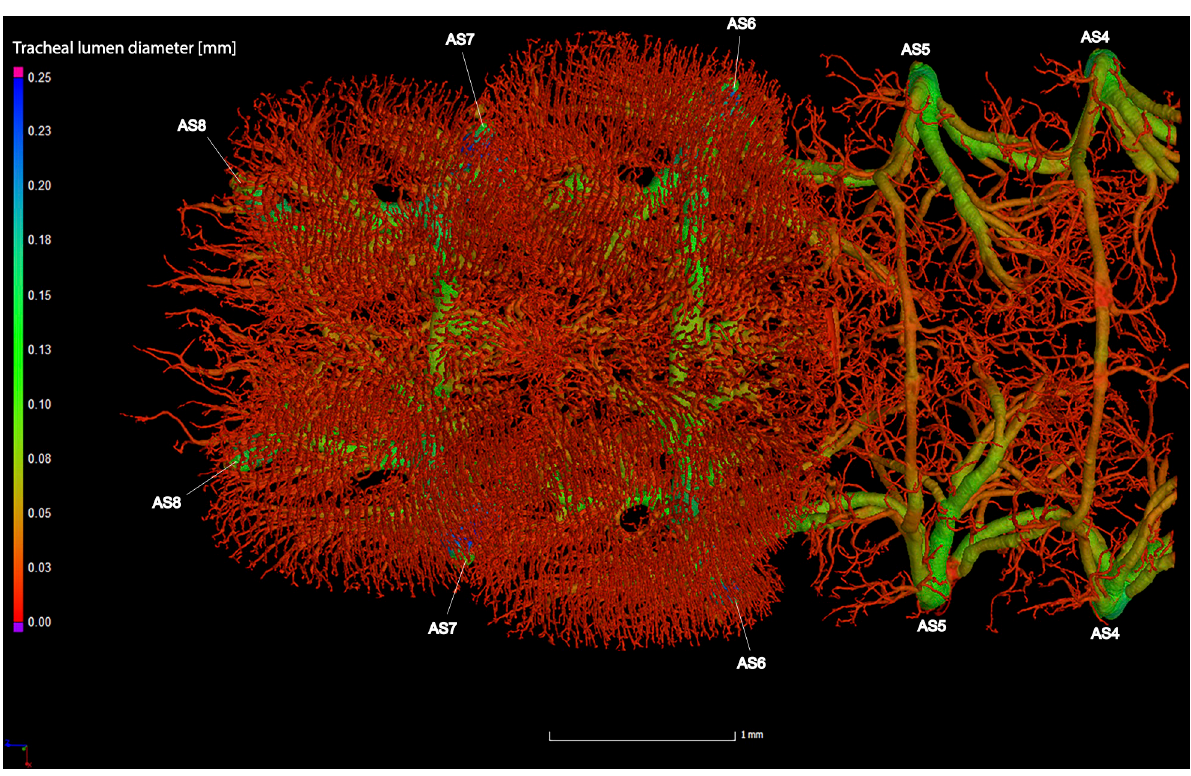
Fig 11. Ventral view of the abdominal tracheal system in adult male Photinus pyralis .